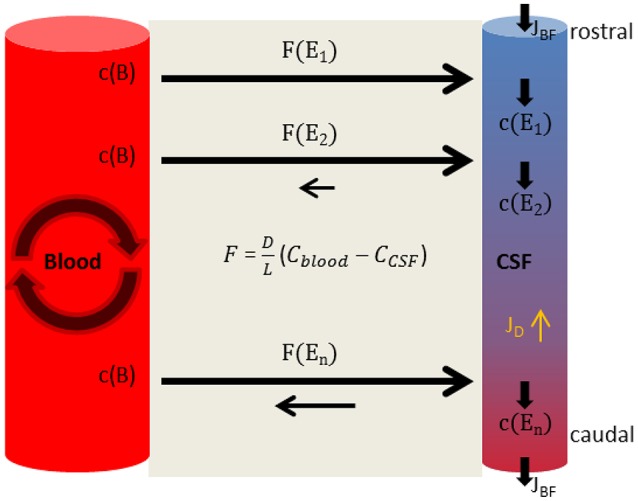
The connected steady state model. The concentration in blood, c(B), is constant. Diffusional loss is equalized by the circulative convection of blood. In consequence the diffusional flux from blood to CSF stays the same at each position. In the CSF system the diffusional uptake of blood-derived substances is in balance with the bulk flow of CSF JBF, so that the concentration at each position c(Ex) remains constant but the concentration of blood-derived substances increases along the flow path of CSF–in consequence the diffusion of blood-derived proteins back to blood increases. At each position the molecular flux rate F(Ex) equates to Equation (5) but is altered by the preceding steady states. The diffusional flux (JD) of blood-derived substances inside the CSF system is inverse to the bulk flow.